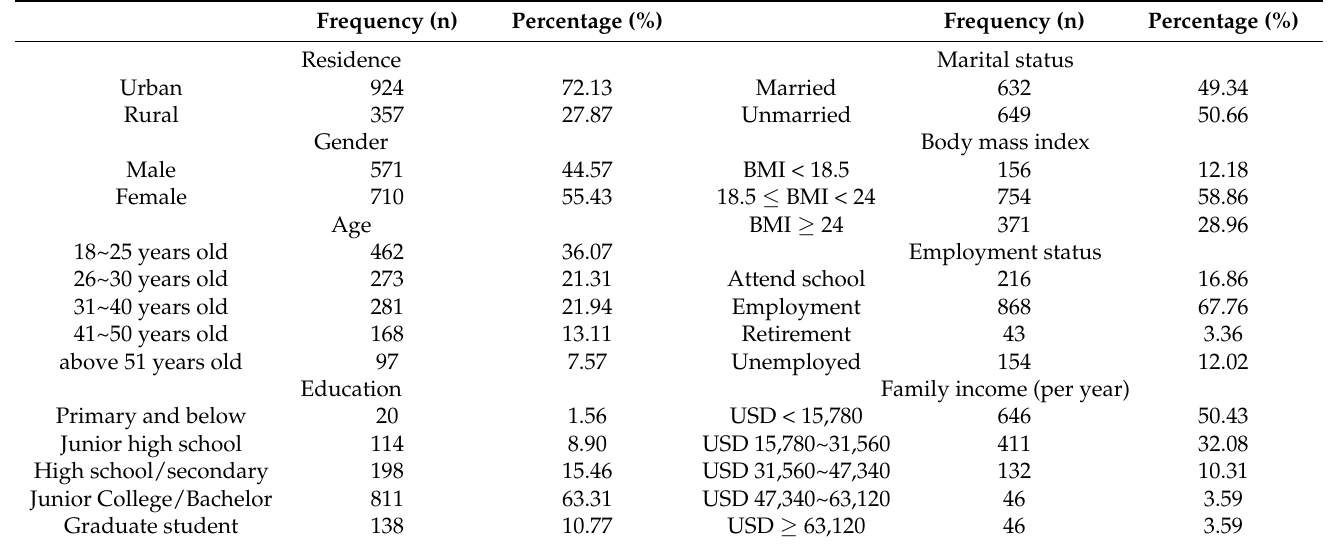
Table 1. Demographic